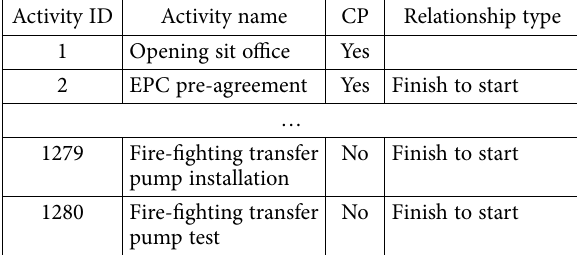
Table 3. Time schedule of the